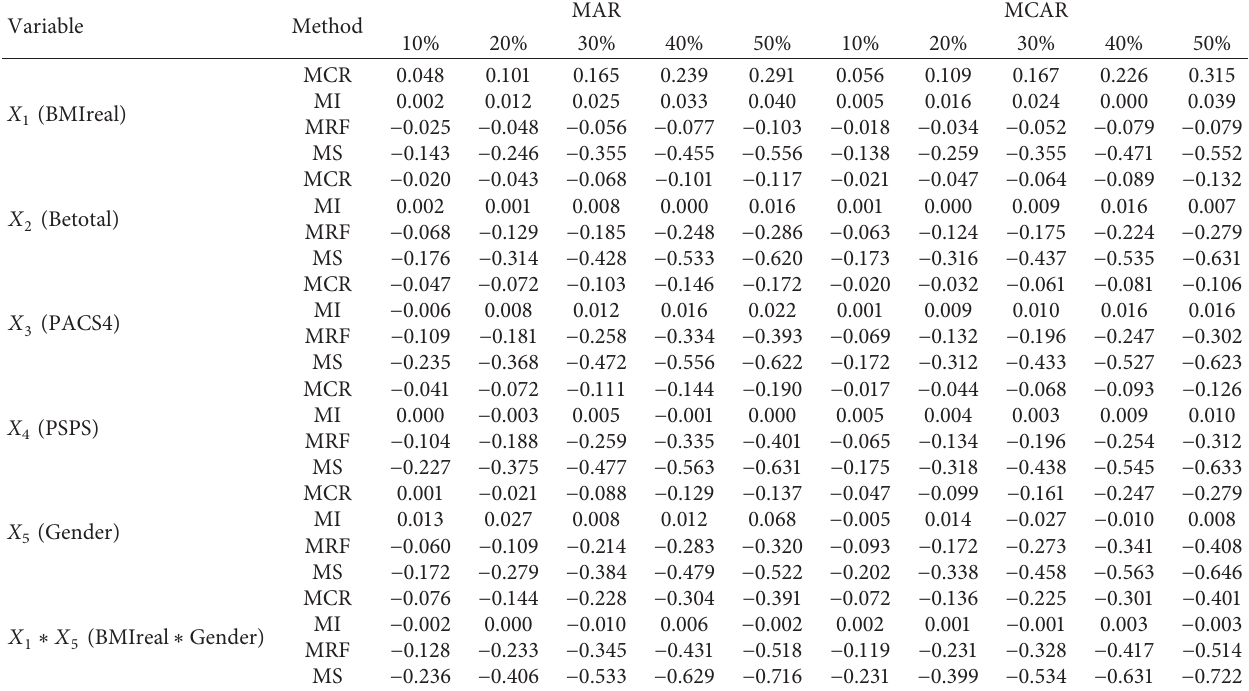
Table 2: Comparison of the performance of imputation methods based on the average percent bias (PB) of regression coefficients over 1000 simulations.